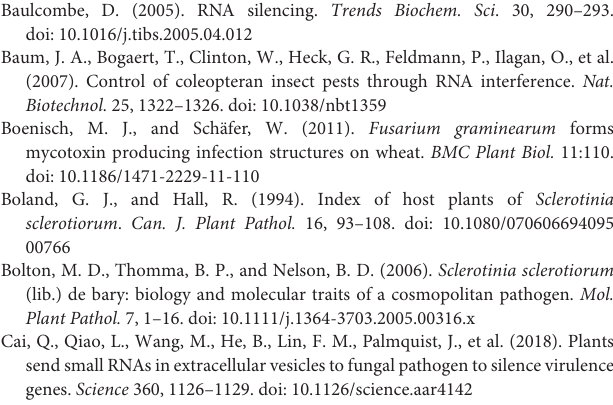
Supplementary Figure 8 | Morphological characterizations of transgenic and control A. thaliana lines. Supplementary Figure 9 | The expression of specific siRNA of Sscnd1 gene ( Sscnd1 -siRNA) in HIGS- Sscnd1 transgenic A. thaliana lines as determined by stem-loop qRT-PCR analysis. The cDNA harboring the loop sequence was used for stem-loop qRT-PCR analysis in Col-0 (wild-type A. thaliana ), EV ( A. thaliana lines containing the empty vector) and HIGS- Sscnd1A. thaliana lines. The quantity of AtU6-26 was used to normalize the expression levels of Sscnd1 siRNA in different samples. Error bars indicate the standard deviation of three independent assays. Supplementary Figure 10 | Gene expression analysis. (A) Relative transcript levels of AtPR1 , AtPR2 , AtPR5 , and AtPDF1.2 genes in the Col-0 (wild-type A. thaliana ), EV ( A. thaliana lines containing the empty vector) and HIGS- Sscnd1 transgenic A. thaliana lines. The quantity of AtActin8 was used to normalize the expression levels of every gene in different samples. Error bars indicate the standard deviation of three independent assays. The relative expression of every gene in EV was set as one. (B) Relative transcript levels of Sscnd1 homologous genes in the S. sclerotiorum -infected HIGS- Sscnd1 lines at 24 hpi. The quantity of Sstub1 was used to normalize the expression levels of every gene in different samples. Error bars indicate the standard deviation of three independent assays. The relative expression of every gene in EV was set as one. Differences in every gene group were assessed using Tukey’s HSD test, respectively. Different letters indicate statistical significance at the 0.05 level ( P < 0.05). Supplementary Figure 11 | Expression of the HIGS- Sscnd1 construct in A. thaliana Col-0 enhances resistance against Botrytis cinerea . (A) Disease phenotypes of Col-0 (wild-type A. thaliana ), EV (empty vector line) and HIGS transgenic lines (HIGS-Sicnd1-25, HIGS-Sicnd1-39, and HIGS-Sicnd1-42) after inoculation with B. cinerea strain B05.10. Photographs were taken at 24 hpi. (B) Quantification of the lesion area in (A) . Error bars indicate the standard deviation for five replicates. Differences were assessed using Tukey’s HSD test. Different letters indicate statistical significance at the 0.05 level ( P < 0.05). (C) Relative transcript levels of BC1G_08931 in the leaves of Col-0, EV, and HIGS transgenic lines 24 hpi with B. cinerea strain B05.10. Total BC1G_08931 cDNA abundance in the samples was normalized using BcActin gene as a control. Error bars indicate the standard deviation of three independent assays. Differences were assessed using Tukey’s HSD test. Different letters indicate statistical significance at the 0.05 level ( P < 0.05). Supplementary Table 1 | Information on the primers used in this study. Supplementary Table 2 | Information of the differentially expressed genes (DEGs) (Sicnd1 [Sicnd1-9 and Sicnd1-20]_vs_ WT). Supplementary Table 3 | Segregation analyses and lesion areas of Col-0 (wild-type A. thaliana ), EV (empty vector line) and HIGS transgenic lines (HIGS-Sicnd1-25, HIGS-Sicnd1-39, and HIGS-Sicnd1-42) after inoculation with S. sclerotiorum